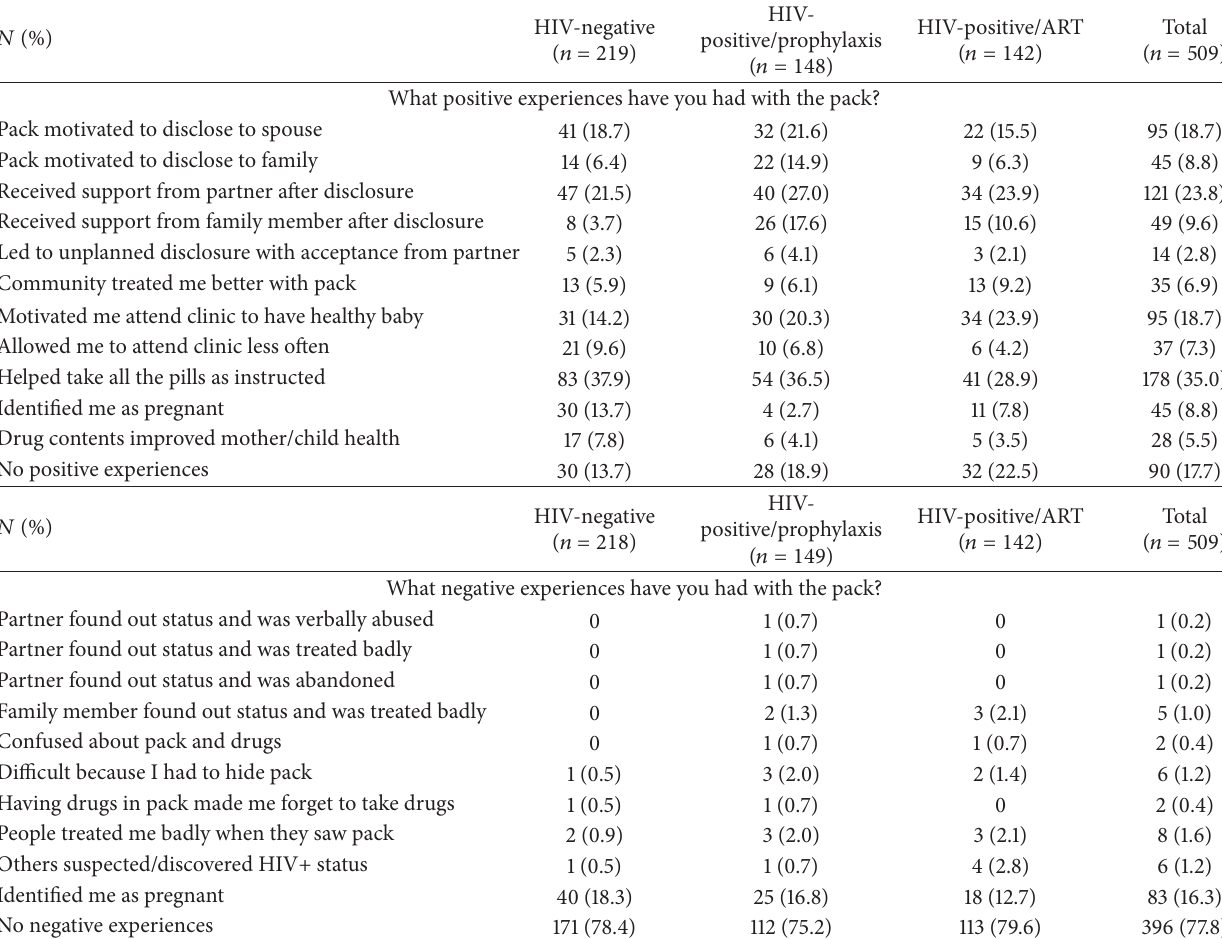
Table 2: Women’s positive and negative experiences with the pack reported in structured interviews. 𝑁